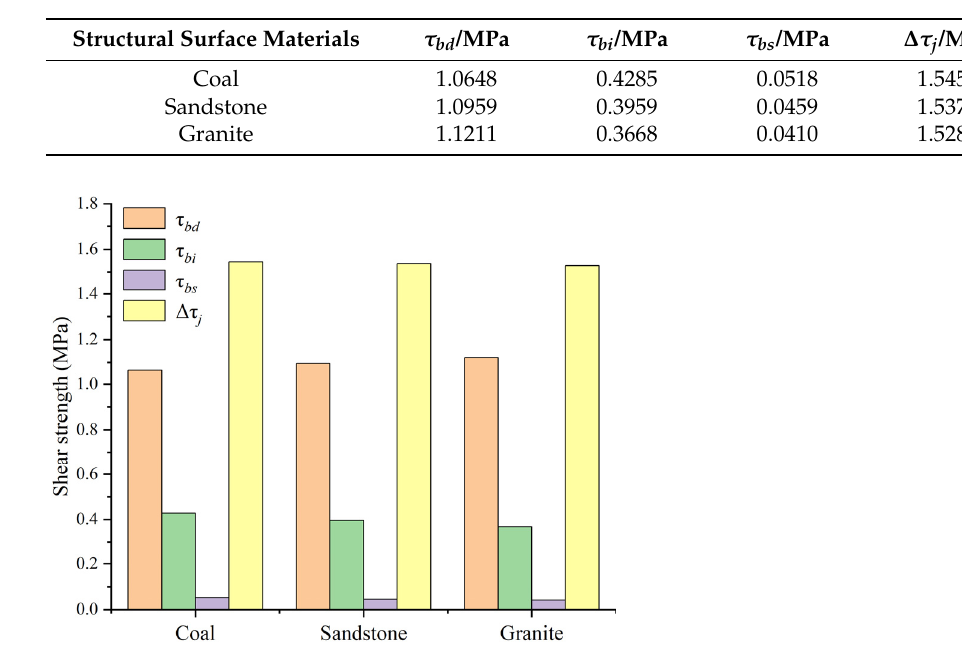
Table 6. Enhancement of the shear strengths of the structural surfaces when the bolt yielded.